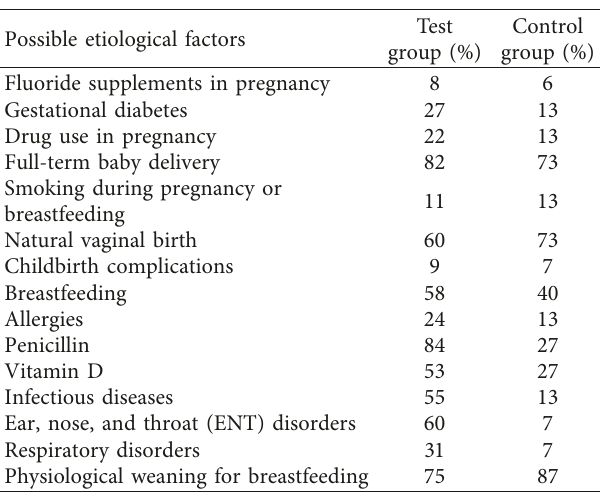
Table 2: Prenatal, perinatal, and postnatal variables (percentages) in the test group (with MIH) and in the controls (without